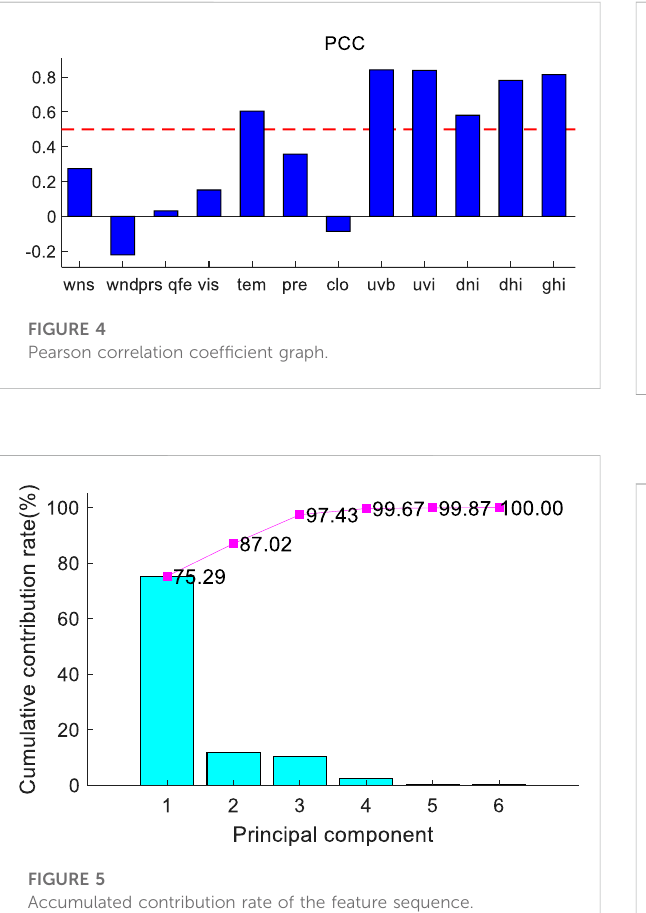
FIGURE 5 Accumulated contribution rate of the feature sequence.